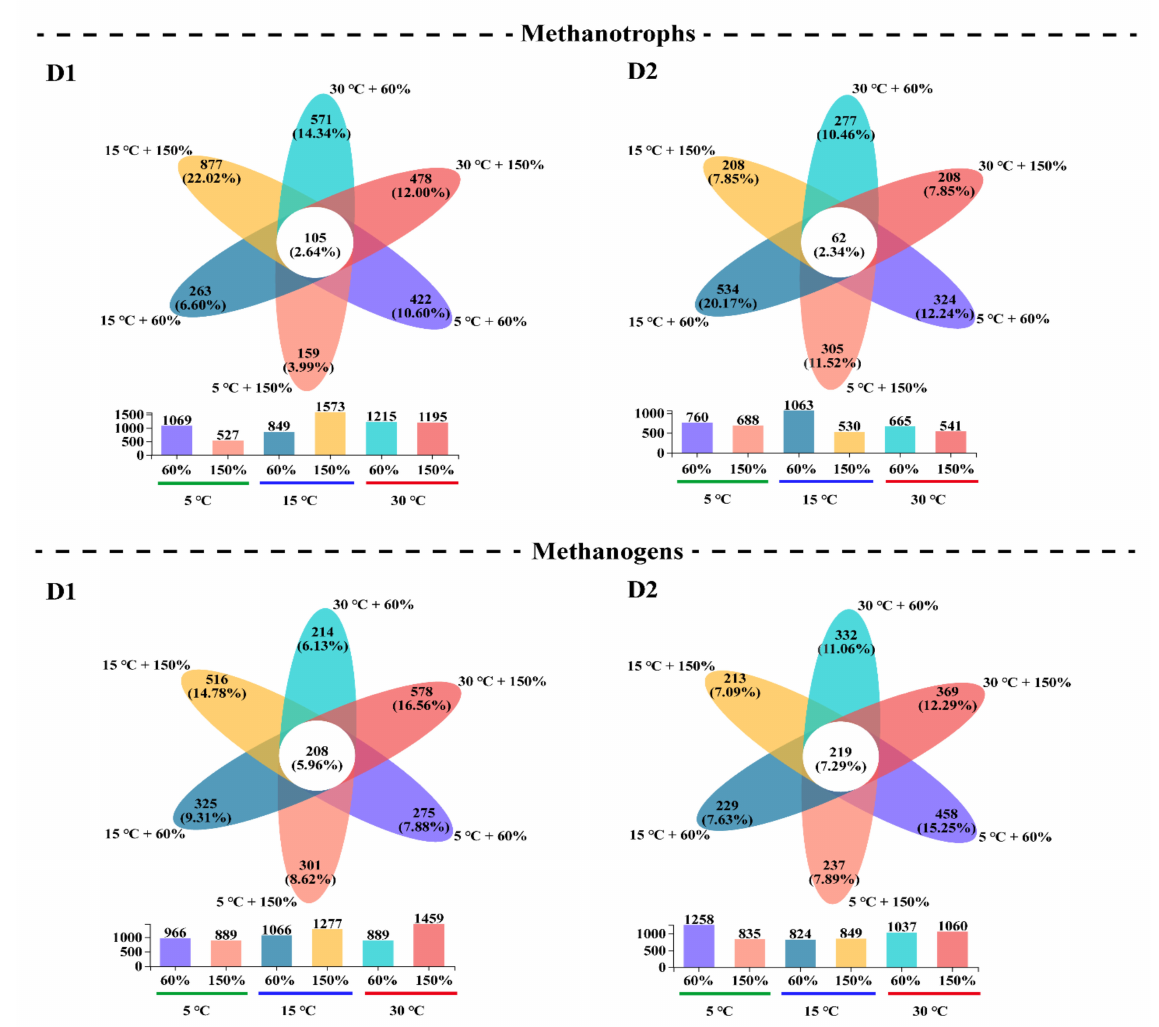
Figure 5. Species composition of methanotrophs (upper figures) and methanogens (lower figures) in soil samples after incubation at temperatures of 5, 15, and 30 ◦ C in combination with soil moisture states of 60% and 150% water-filled pore space. Samples from two soil depths were incubated: D1 (0–20 cm) and D2 (20–50 cm). The core indicates the number of shared species (OTUs). The petals indicate the number of unique species (OTUs). The bar charts show the total species number for each treatment. OTU: operational taxonomic